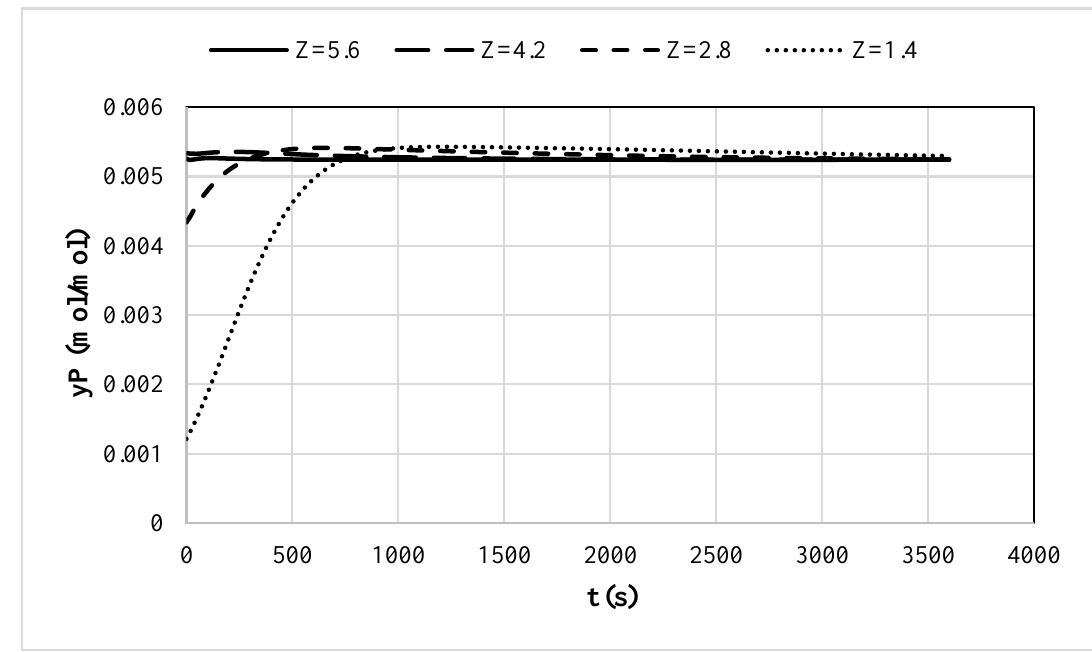
Figure 15. Pentane output mole fraction in four different zones of the bed. Figure 16 illustrates the hexane concentration variation versus time in four different heights (Z = 1.4, Z = 2.8, Z = 4.2, Z = 5.6) of the bed. Hexane adsorption was higher than the pentane and occurred up to the last moment in function.